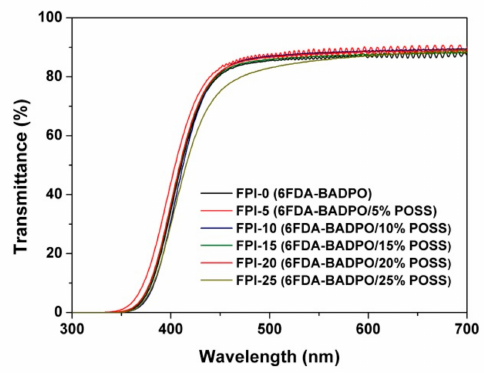
Figure 10. Ultraviolet-visible (UV-Vis) spectra of FPI-TSP films.